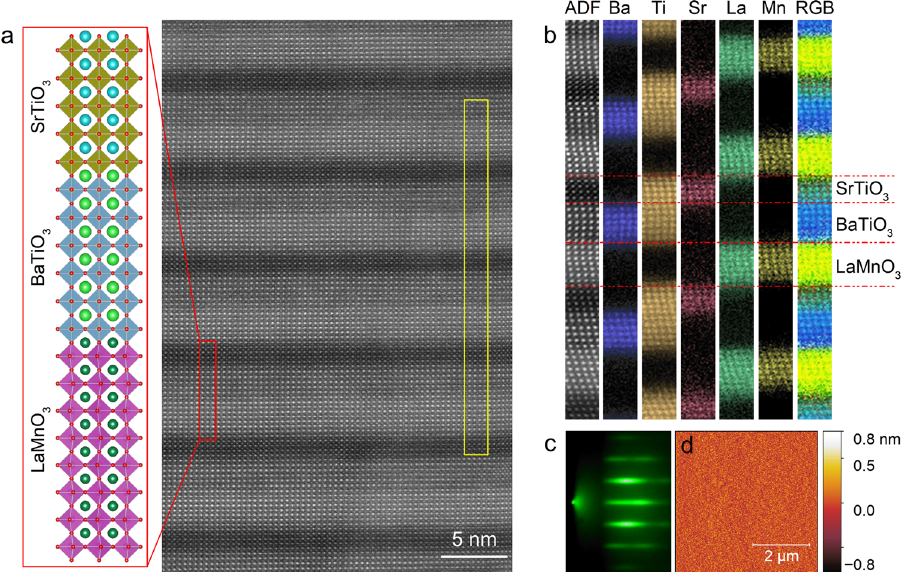
Fig. 1 Fabrication of LMO/BTO/STO SLs on Si/STO. a HAADF-STEM image of the L 8 B 6 S 5 SL grown on Si/STO. The sketch on the left shows the ideal atomic structure in one period. The EELS elemental maps taken from the yellow rectangular area are shown in ( b ). c , d Show the RHEED image taken along the Si[110] azimuth and AFM image of the L 8 B 6 S 5